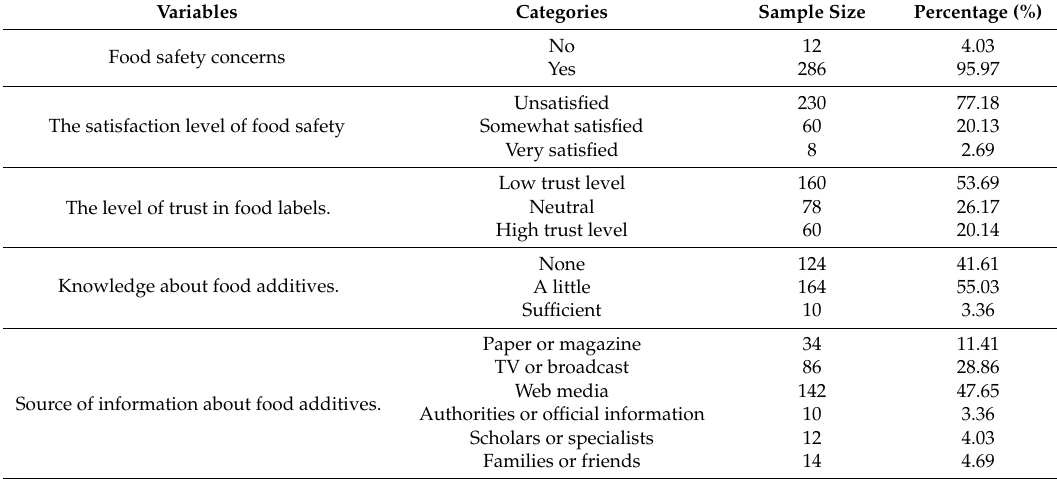
Table 5. Food safety and information about